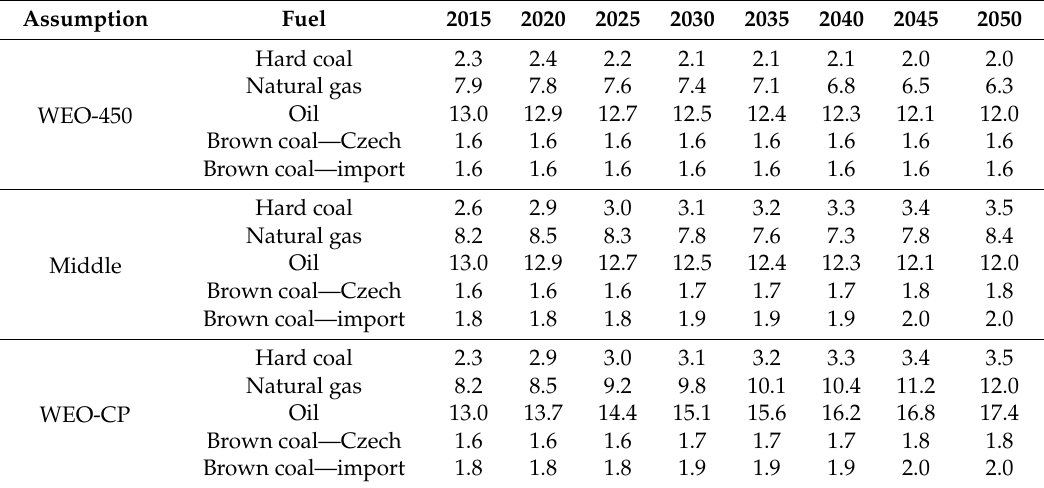
Table 1. Fuel prices as assumed in the TIMES-CZ model ( € /GJ).